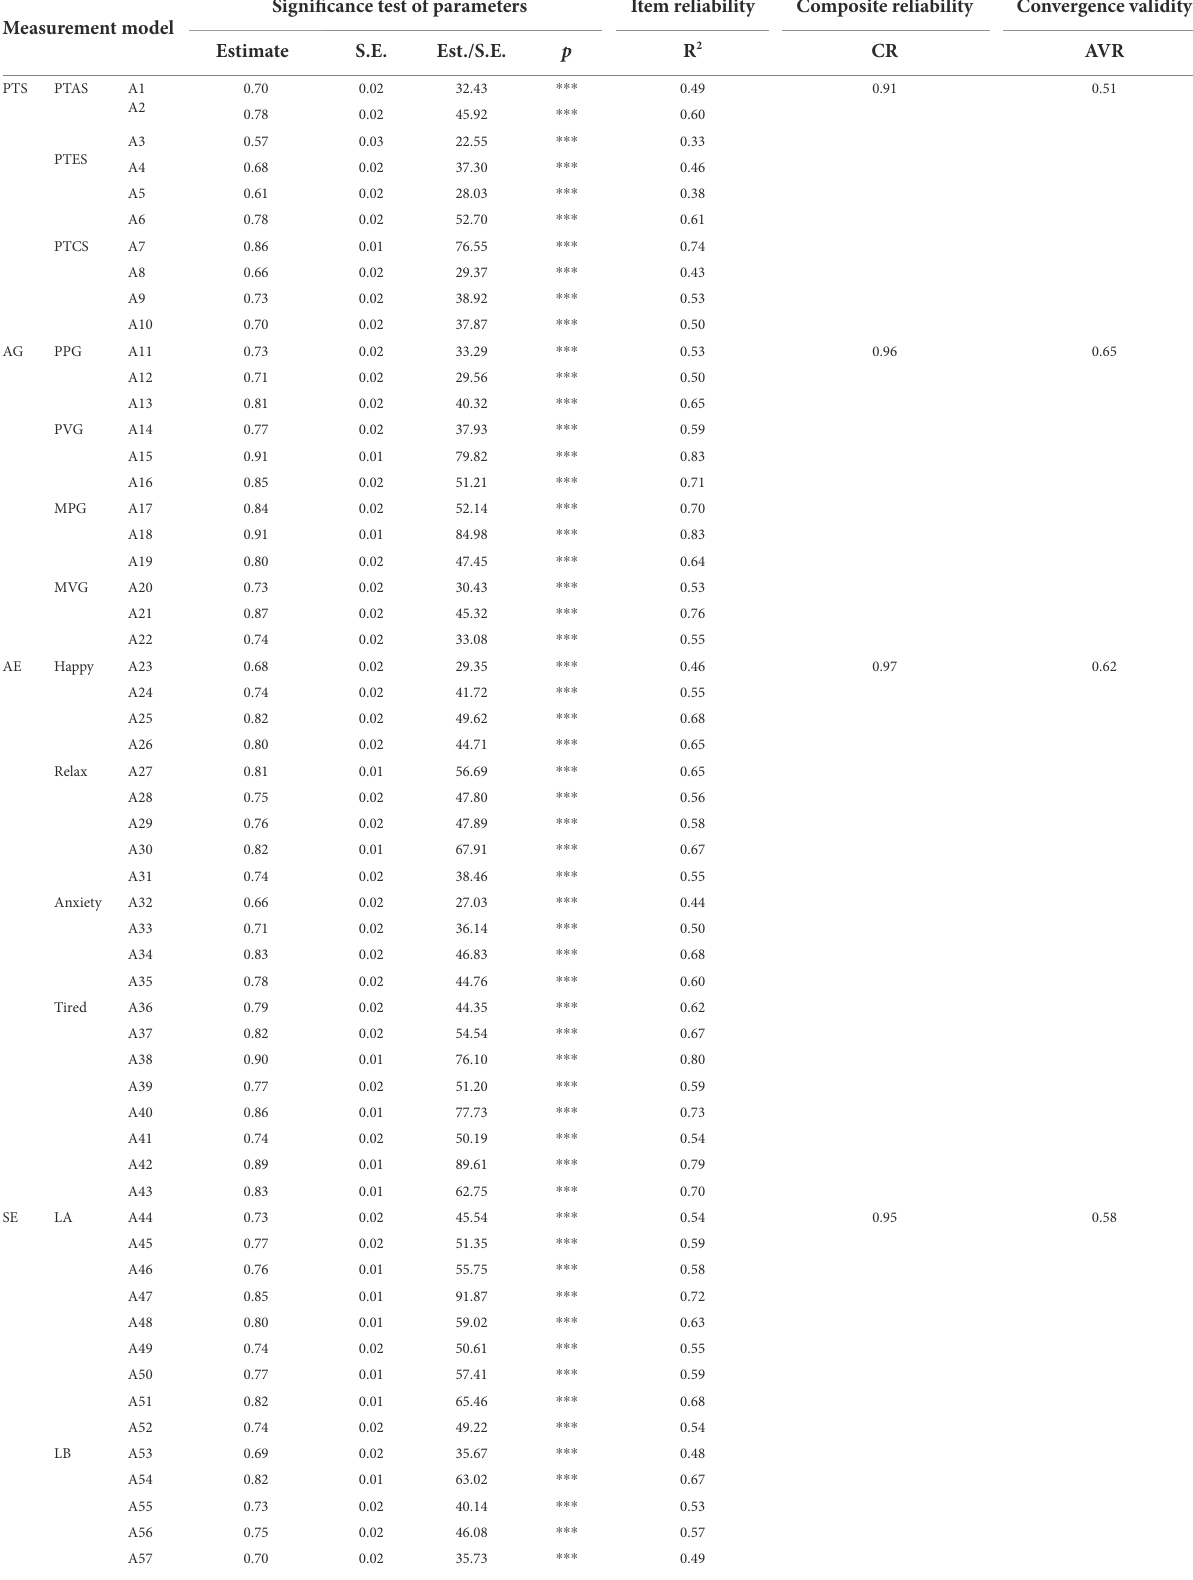
TABLE 3 The reliability and convergence validity of the measurement model.